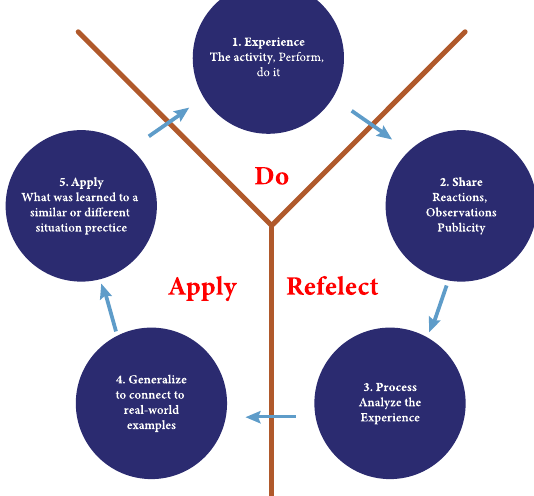
Figure 2: Pfeiffer and Jones experiential learning cycle